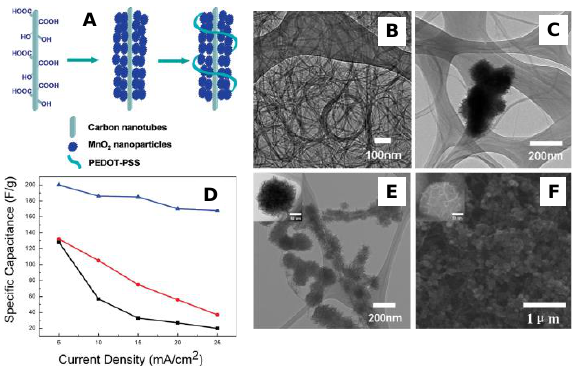
Figure 5. ( A ) Sketch of MnO 2 /CNTs/PEDOT-PSS ternary composite formation; ( B ) TEM image of fFWNTs, ( C ) TEM image of direct mixing of MnO 2 nanospheres with fFWNTs, and ( E ) TEM and ( F ) SEM images of PEDOT-PSS dispersed MnO2 nanospheres in situ grown on fFWNTs; ( D ) Specific capacitance of MnO 2 /fFWNT/PEDOT-PSS ternary composite (blue), MnO 2 /PEDOT-PSS composite (red), and MnO 2 film (black) at different charge/discharge current densities. Reproduced with permission from Reference [60]. Copyright © 2010, American Chemical Society.